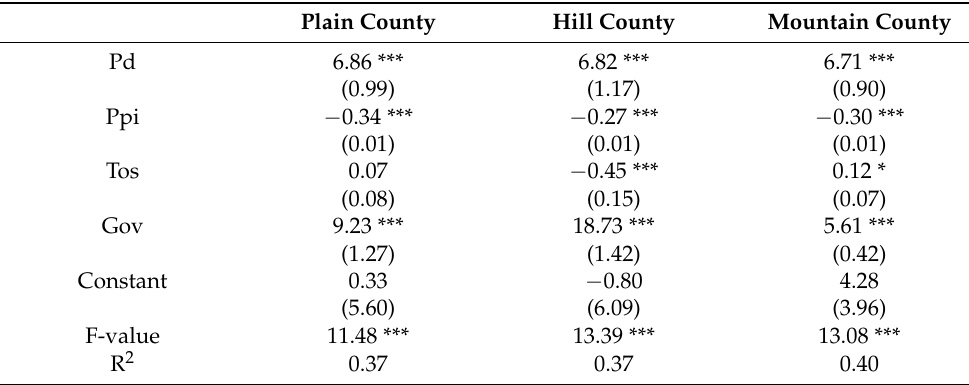
Table 4. Regression results of different types of